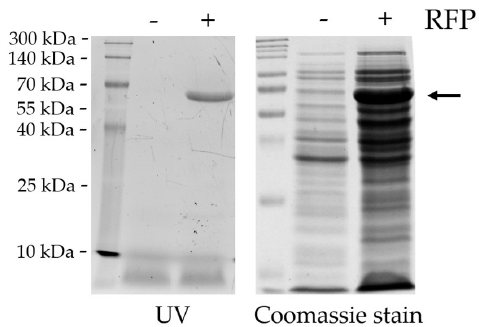
Figure 8. SDS-PAGE analysis of the lysates of non-transformed (RFP − ) and transformed (RFP+) BL21(DE3) cells. Arrow shows His 6 -MBP-VSQNYPIVQ-mEYFP protein substrate (~72 kDa) detected in the cell lysates of transformed cells. Before UV transillumination, the proteins were renatured in the gel after separation by reducing SDS-PAGE (using 14% gel), then the gel was stained with Coomassie